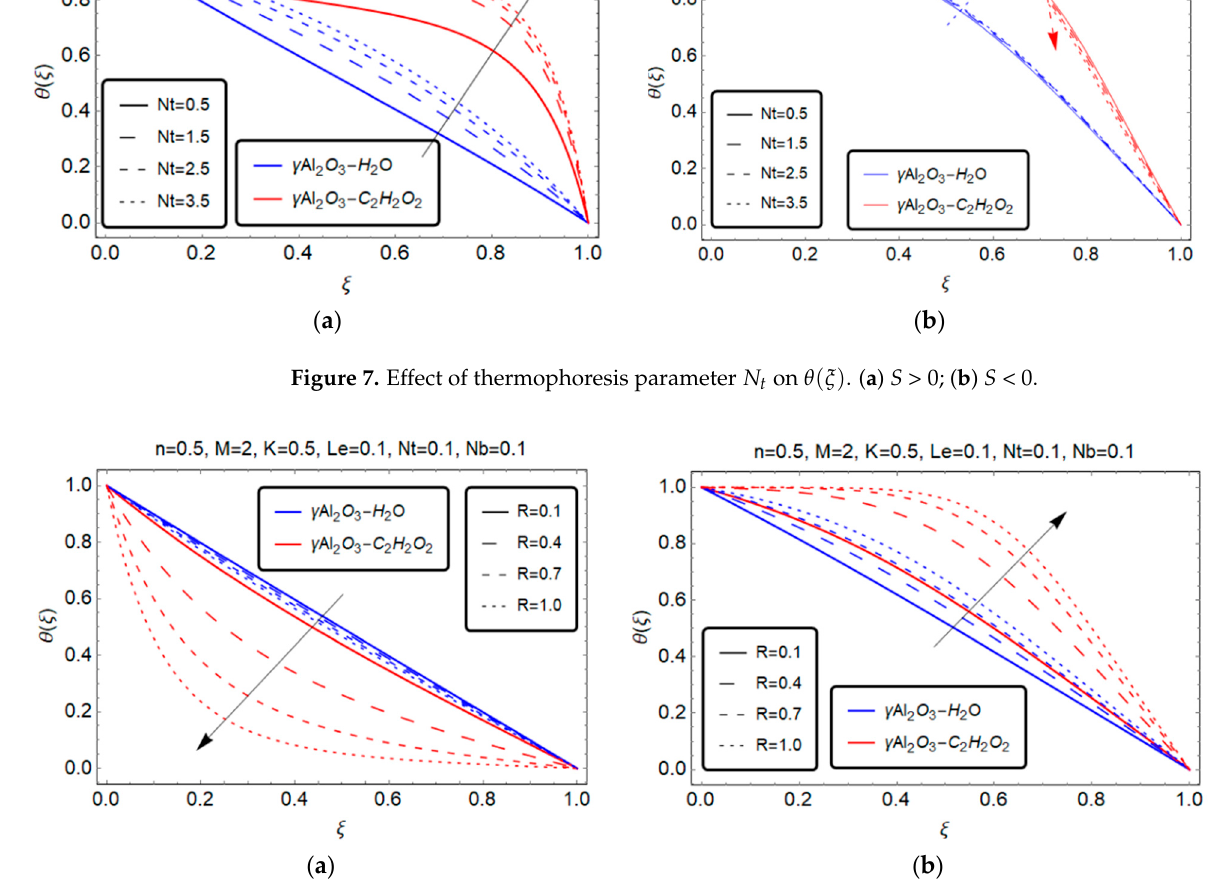
thermophoresis parameter N t for both models γ Al 2 O 3 − H 2 O and γ Al 2 O 3 − C 2 H 6 O 2